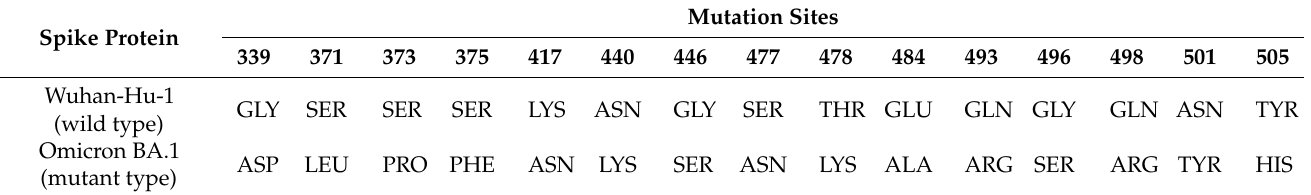
Table 1. Mutation sites in the RBD of Omicron BA.1 and the original residues of SARS-CoV-2. Mutation